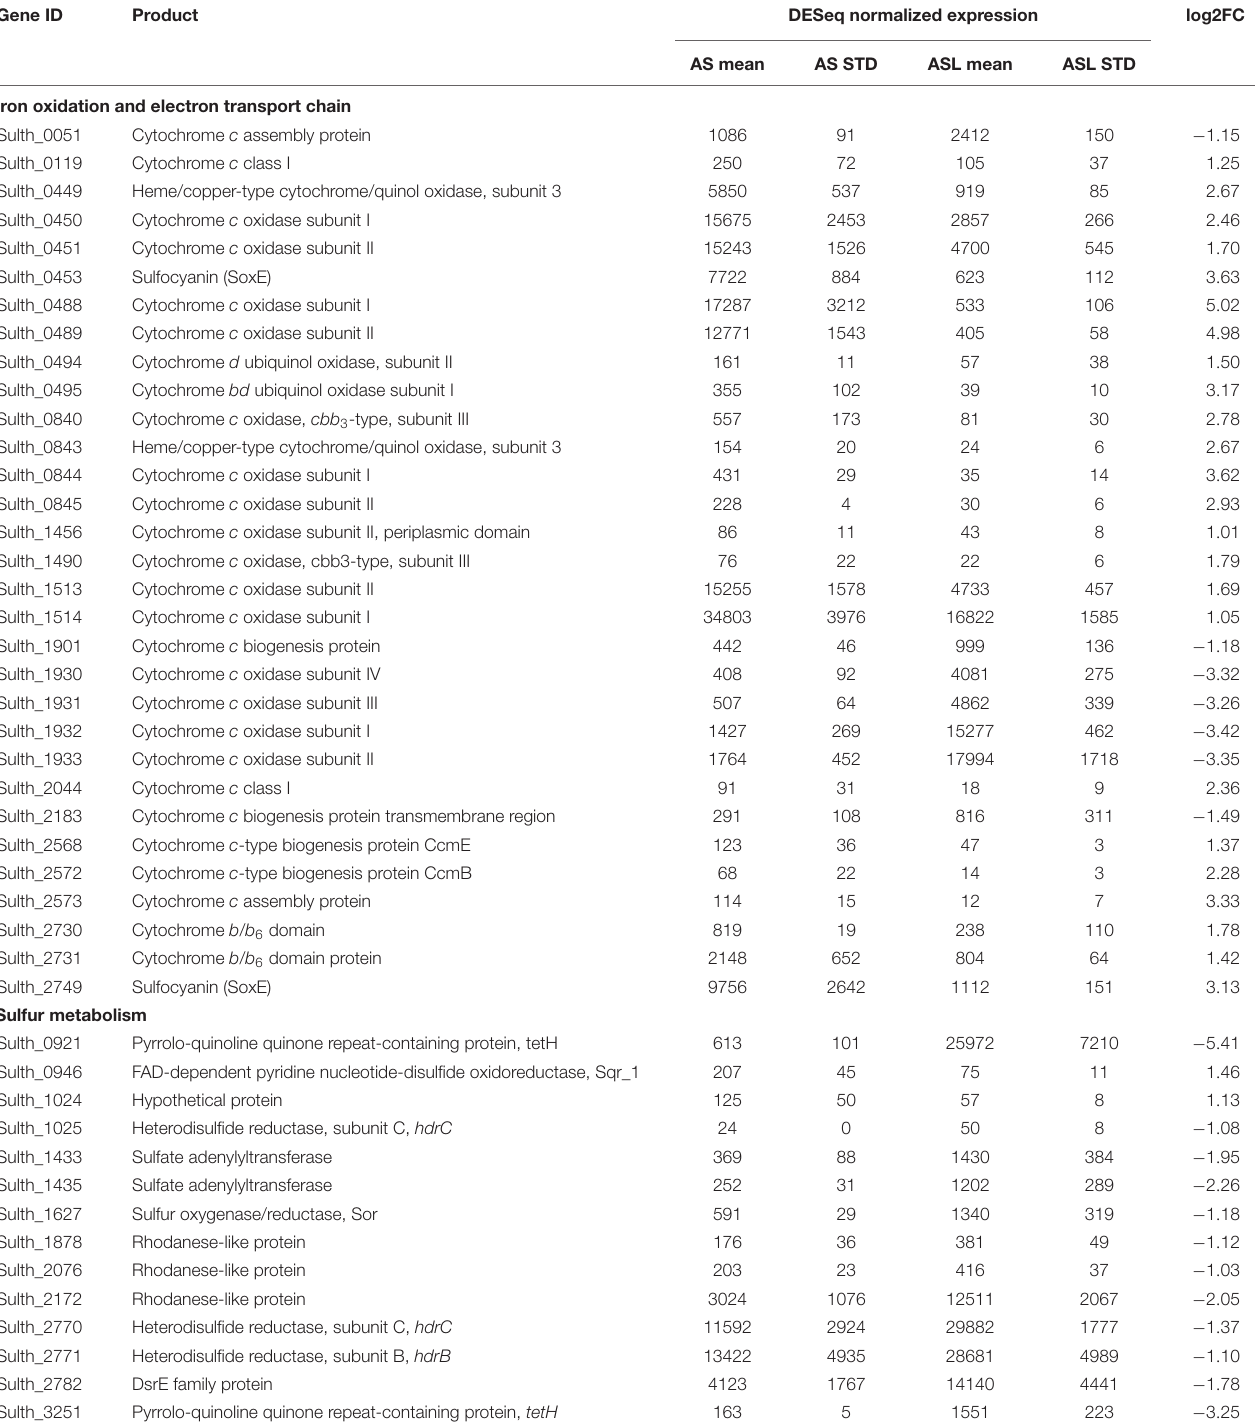
TABLE 1 | Excerpt of Supplementary Table 1 showing significant (|log2FC| ≥ 1.0, p ≤ 0.05) differential expression of S. thermosulfidooxidans genes related to iron and sulfur oxidation as well as electron